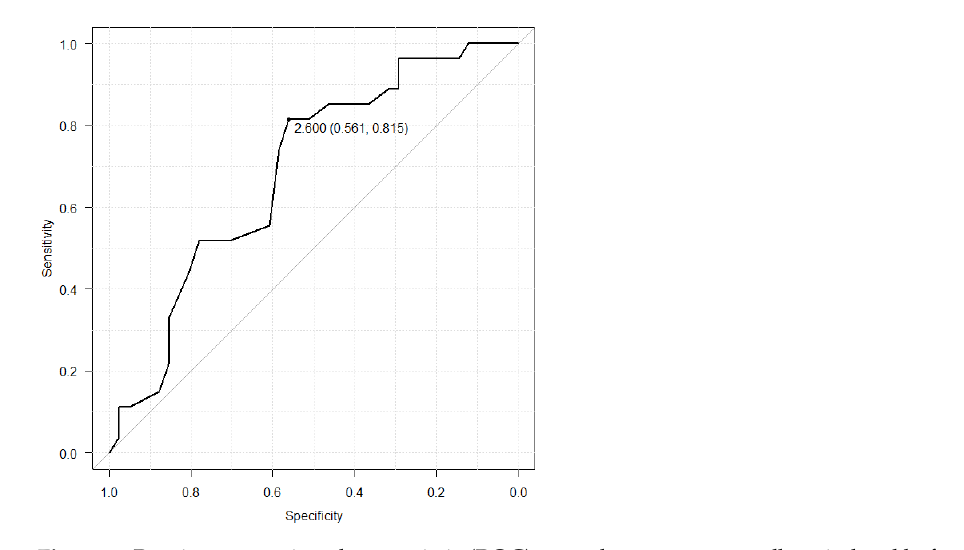
Figure 2. Receiver operating characteristic (ROC) curve between serum albumin level before LZD treatment and hyponatremia.